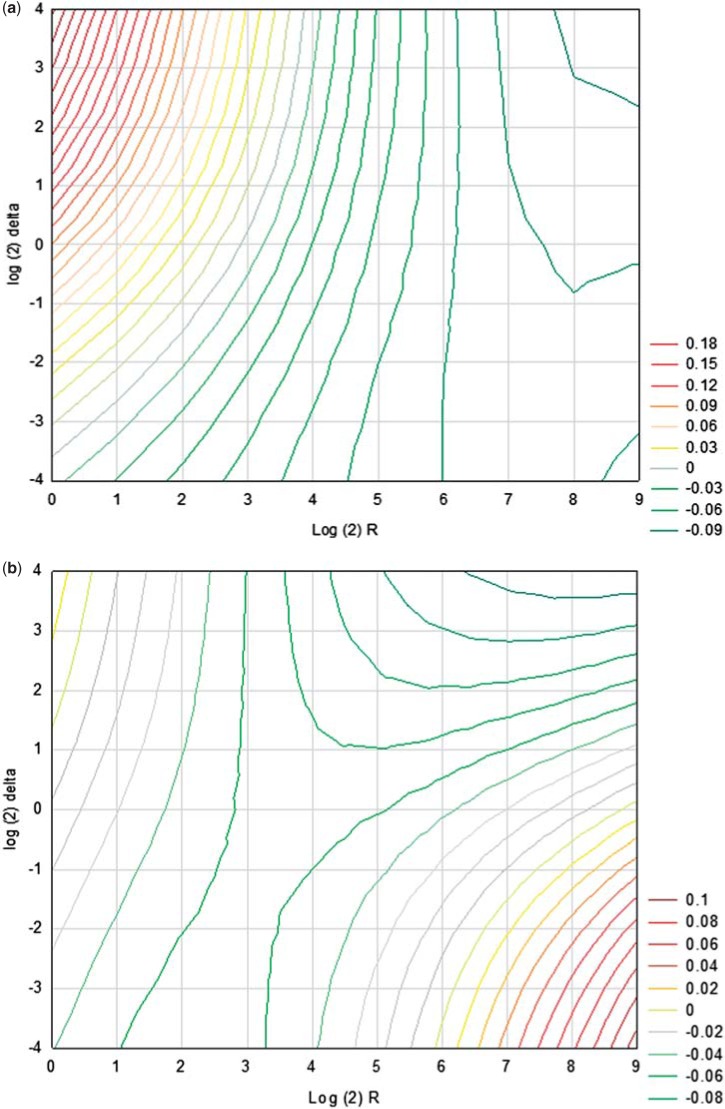
The difference in power as a function of \documentclass[12pt]{minimal}
\usepackage{amsmath}
\usepackage{wasysym}
\usepackage{amsfonts}
\usepackage{amssymb}
\usepackage{amsbsy}
\usepackage{upgreek}
\usepackage{mathrsfs}
\setlength{\oddsidemargin}{-69pt}
\begin{document}
}{}$R$\end{document} and \documentclass[12pt]{minimal}
\usepackage{amsmath}
\usepackage{wasysym}
\usepackage{amsfonts}
\usepackage{amssymb}
\usepackage{amsbsy}
\usepackage{upgreek}
\usepackage{mathrsfs}
\setlength{\oddsidemargin}{-69pt}
\begin{document}
}{}$\delta$\end{document}: (a) HWF weighted power = wBH weighted power for \documentclass[12pt]{minimal}
\usepackage{amsmath}
\usepackage{wasysym}
\usepackage{amsfonts}
\usepackage{amssymb}
\usepackage{amsbsy}
\usepackage{upgreek}
\usepackage{mathrsfs}
\setlength{\oddsidemargin}{-69pt}
\begin{document}
}{}$\mu_p =2$\end{document}, \documentclass[12pt]{minimal}
\usepackage{amsmath}
\usepackage{wasysym}
\usepackage{amsfonts}
\usepackage{amssymb}
\usepackage{amsbsy}
\usepackage{upgreek}
\usepackage{mathrsfs}
\setlength{\oddsidemargin}{-69pt}
\begin{document}
}{}$S=16$\end{document}, \documentclass[12pt]{minimal}
\usepackage{amsmath}
\usepackage{wasysym}
\usepackage{amsfonts}
\usepackage{amssymb}
\usepackage{amsbsy}
\usepackage{upgreek}
\usepackage{mathrsfs}
\setlength{\oddsidemargin}{-69pt}
\begin{document}
}{}$m_1S/S=0.25$\end{document}, \documentclass[12pt]{minimal}
\usepackage{amsmath}
\usepackage{wasysym}
\usepackage{amsfonts}
\usepackage{amssymb}
\usepackage{amsbsy}
\usepackage{upgreek}
\usepackage{mathrsfs}
\setlength{\oddsidemargin}{-69pt}
\begin{document}
}{}$\mu_S=1.5$\end{document}, \documentclass[12pt]{minimal}
\usepackage{amsmath}
\usepackage{wasysym}
\usepackage{amsfonts}
\usepackage{amssymb}
\usepackage{amsbsy}
\usepackage{upgreek}
\usepackage{mathrsfs}
\setlength{\oddsidemargin}{-69pt}
\begin{document}
}{}$\mu_{S_1}=6$\end{document} and (b) HWF weighted power – wBH weighted power for \documentclass[12pt]{minimal}
\usepackage{amsmath}
\usepackage{wasysym}
\usepackage{amsfonts}
\usepackage{amssymb}
\usepackage{amsbsy}
\usepackage{upgreek}
\usepackage{mathrsfs}
\setlength{\oddsidemargin}{-69pt}
\begin{document}
}{}$\mu_p=2$\end{document}, \documentclass[12pt]{minimal}
\usepackage{amsmath}
\usepackage{wasysym}
\usepackage{amsfonts}
\usepackage{amssymb}
\usepackage{amsbsy}
\usepackage{upgreek}
\usepackage{mathrsfs}
\setlength{\oddsidemargin}{-69pt}
\begin{document}
}{}$S=16$\end{document}, \documentclass[12pt]{minimal}
\usepackage{amsmath}
\usepackage{wasysym}
\usepackage{amsfonts}
\usepackage{amssymb}
\usepackage{amsbsy}
\usepackage{upgreek}
\usepackage{mathrsfs}
\setlength{\oddsidemargin}{-69pt}
\begin{document}
}{}$m_1S/S=0.75$\end{document}, \documentclass[12pt]{minimal}
\usepackage{amsmath}
\usepackage{wasysym}
\usepackage{amsfonts}
\usepackage{amssymb}
\usepackage{amsbsy}
\usepackage{upgreek}
\usepackage{mathrsfs}
\setlength{\oddsidemargin}{-69pt}
\begin{document}
}{}$\mu_S=3$\end{document}, \documentclass[12pt]{minimal}
\usepackage{amsmath}
\usepackage{wasysym}
\usepackage{amsfonts}
\usepackage{amssymb}
\usepackage{amsbsy}
\usepackage{upgreek}
\usepackage{mathrsfs}
\setlength{\oddsidemargin}{-69pt}
\begin{document}
}{}$\mu_{S_1}=6$\end{document}.